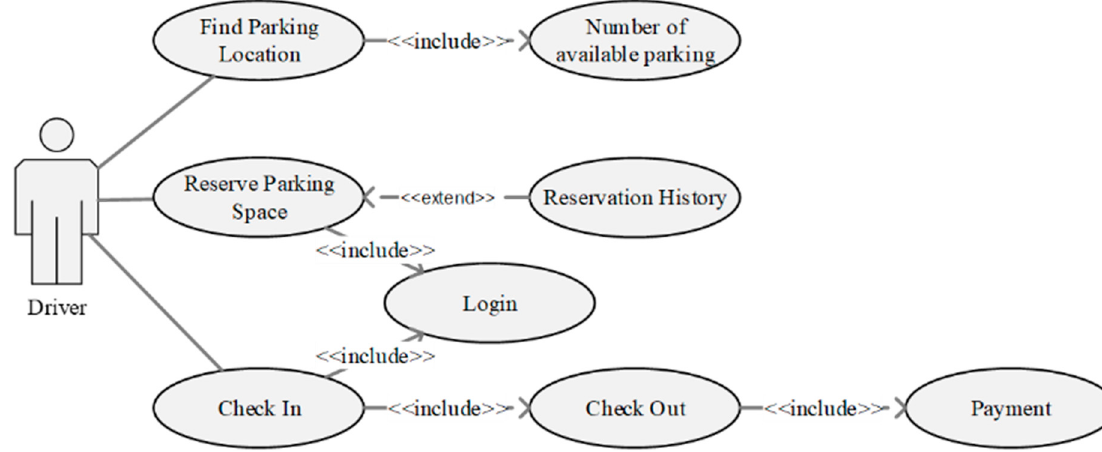
Figure 9. Reservation use case diagram for driver.